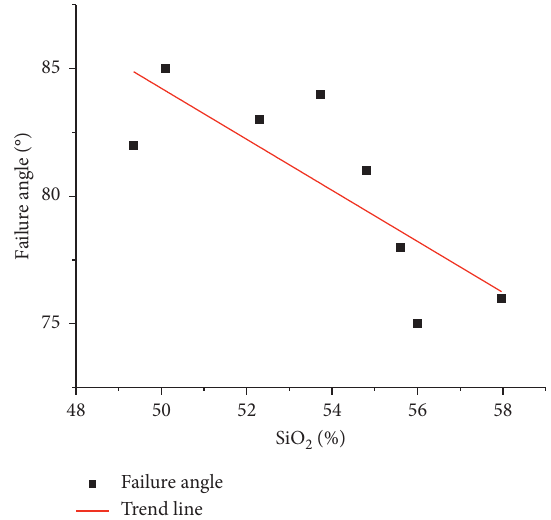
Figure 10: Relationship between mineral composition and failure angle of deep sandstone reservoir.